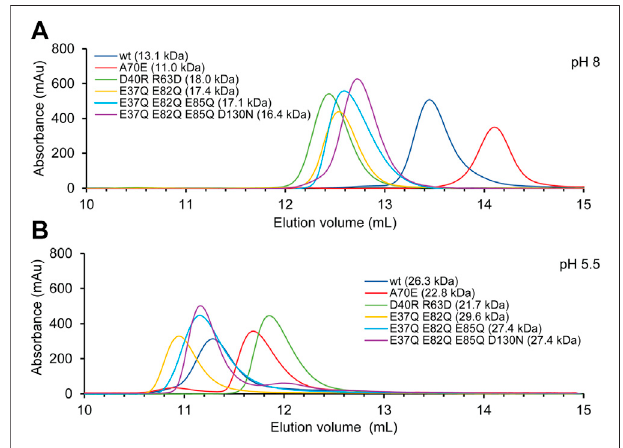
FIGURE 4 | TuSp NT dimerization analysis by size exclusion chromatography performed in (A) 20 mM Tris-HCl, 300 mM NaCl, at pH 8 and (B) 20 mM NaOAc, 20 mM NaCl at pH